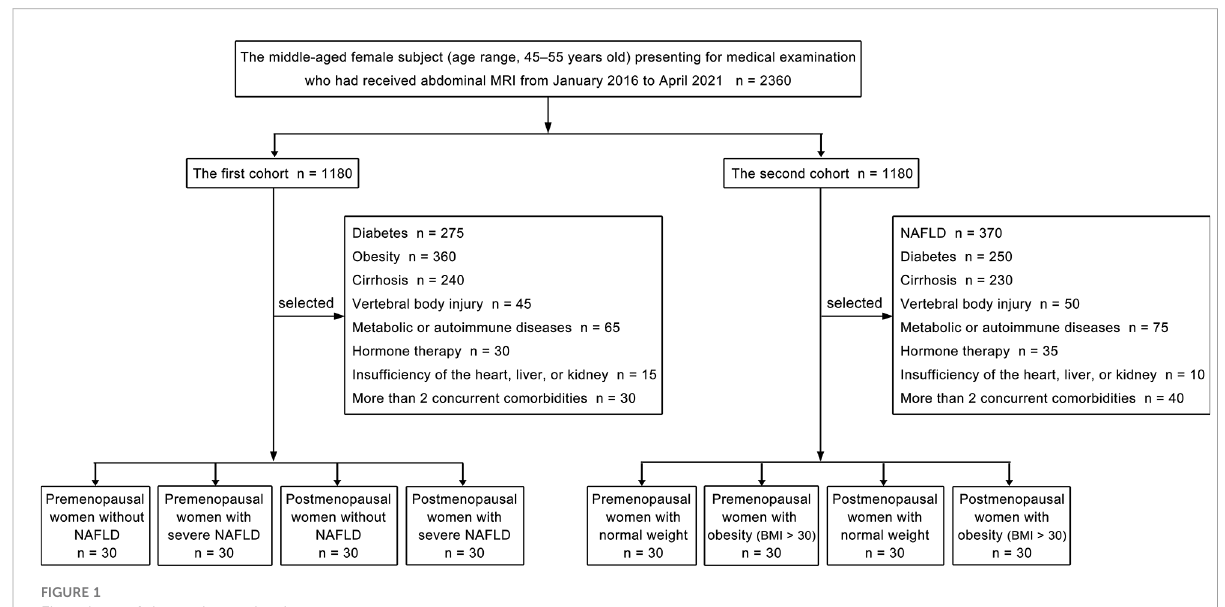
FIGURE 1 Flowchart of the patient selection